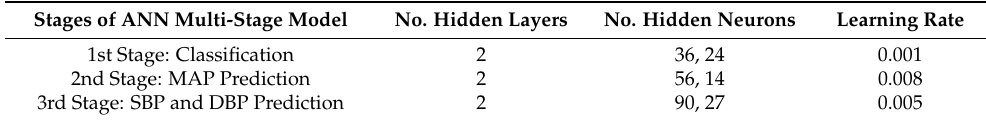
Table 6. ANN Multi-Stage Model Design Parameters.